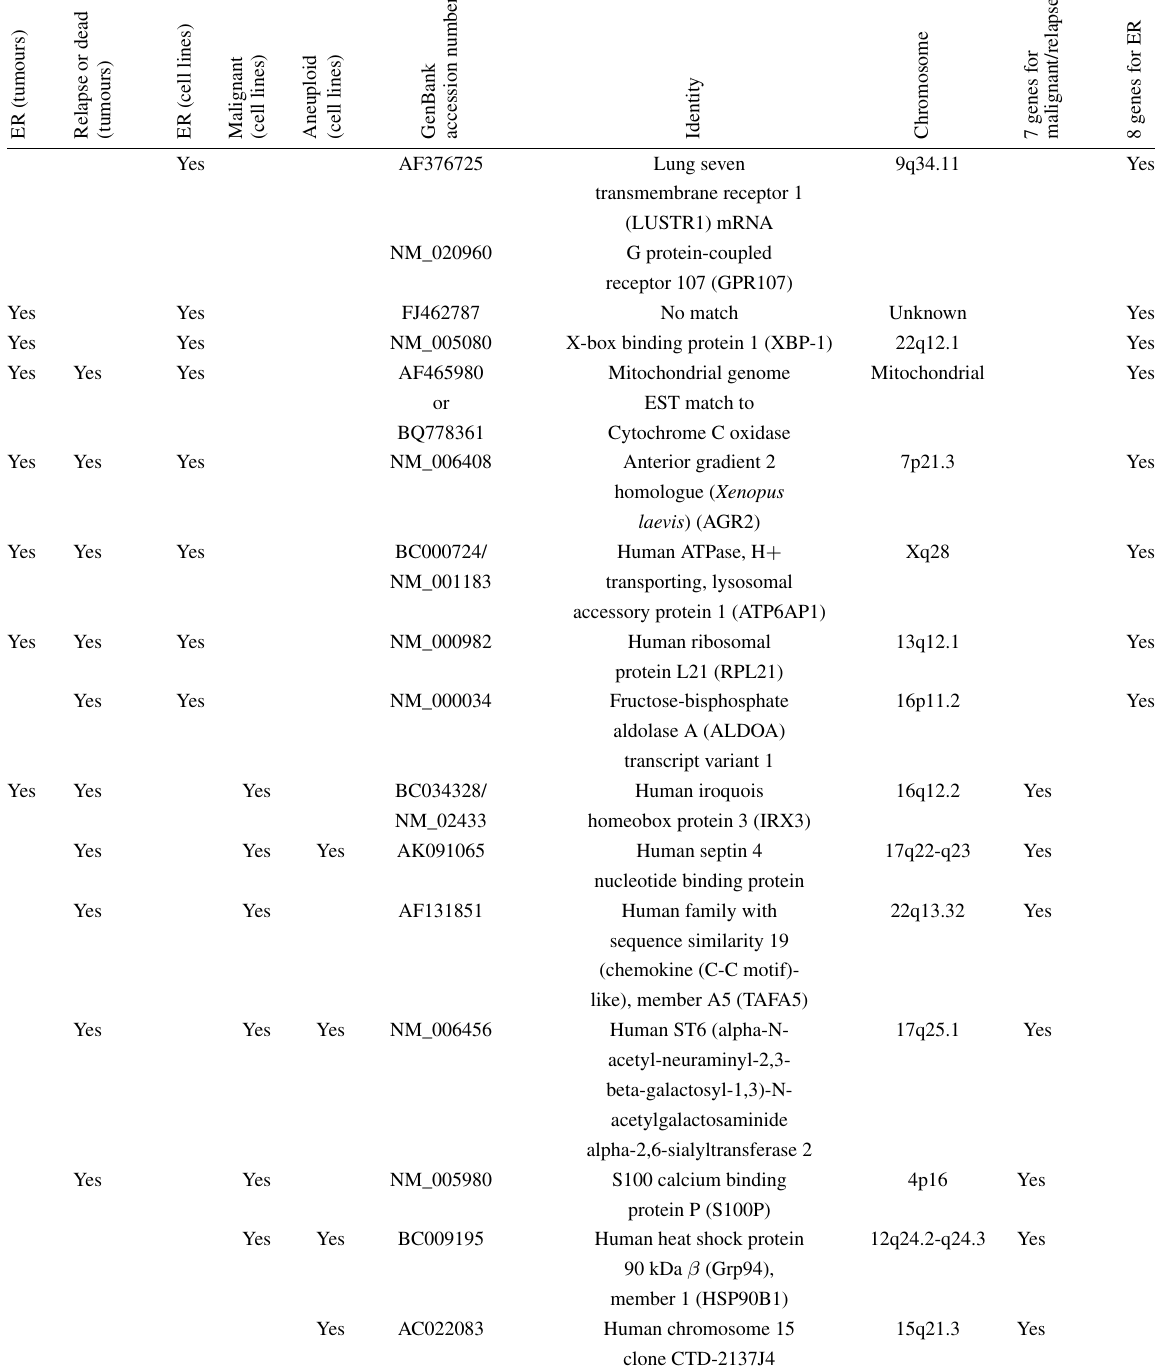
Panel of 8 expressed genes, which clustered for ER α and 7 expressed genes, which clustered for malignant or aneuploidy (cell lines) and/or relapse (carcinomas)